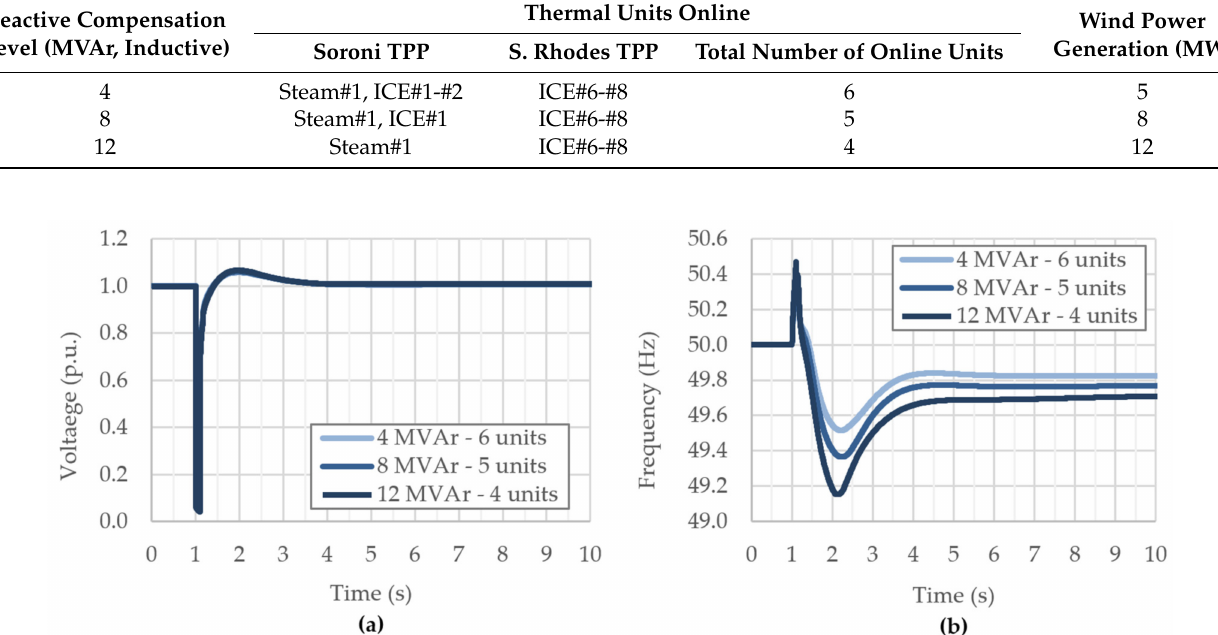
Figure 13. HV bus voltage ( a ) and frequency ( b ) at Soroni TPP—generator